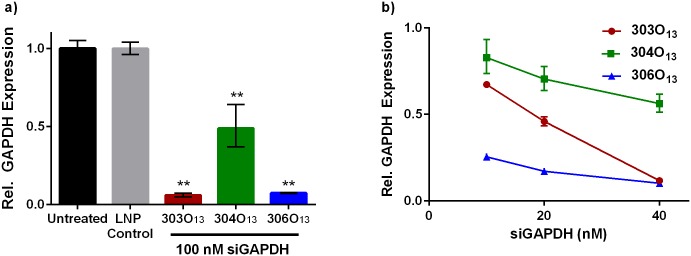
All three LNPs facilitated GAPDH mRNA silencing in Caco-2 cells.
A) LNPs 306O13 and 303O13 mediated ~90% silencing at an siRNA dose of 100 nM while control LNPs containing off-targeted siRNA did not induce statistically significant changes in gene expression. ** p < 0.001 as determined by an unpaired student’s t-test to the untreated control. B) The 306O13 LNPs had the most potent dose-dependent GAPDH gene silencing in Caco-2 cells. The LNP control consisted of 100 nM siGFP 306O13 LNPs. Error bars represent s.d. (n = 3).